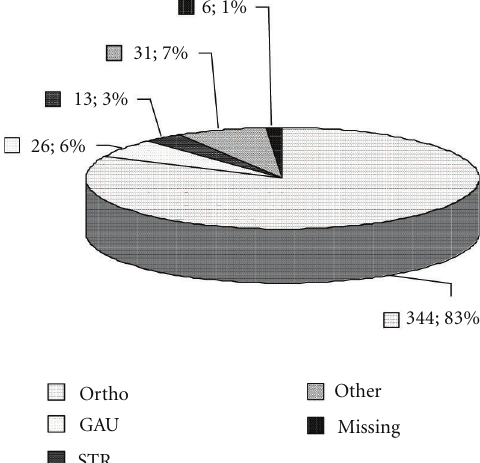
Figure 1: Ward location on discharge.